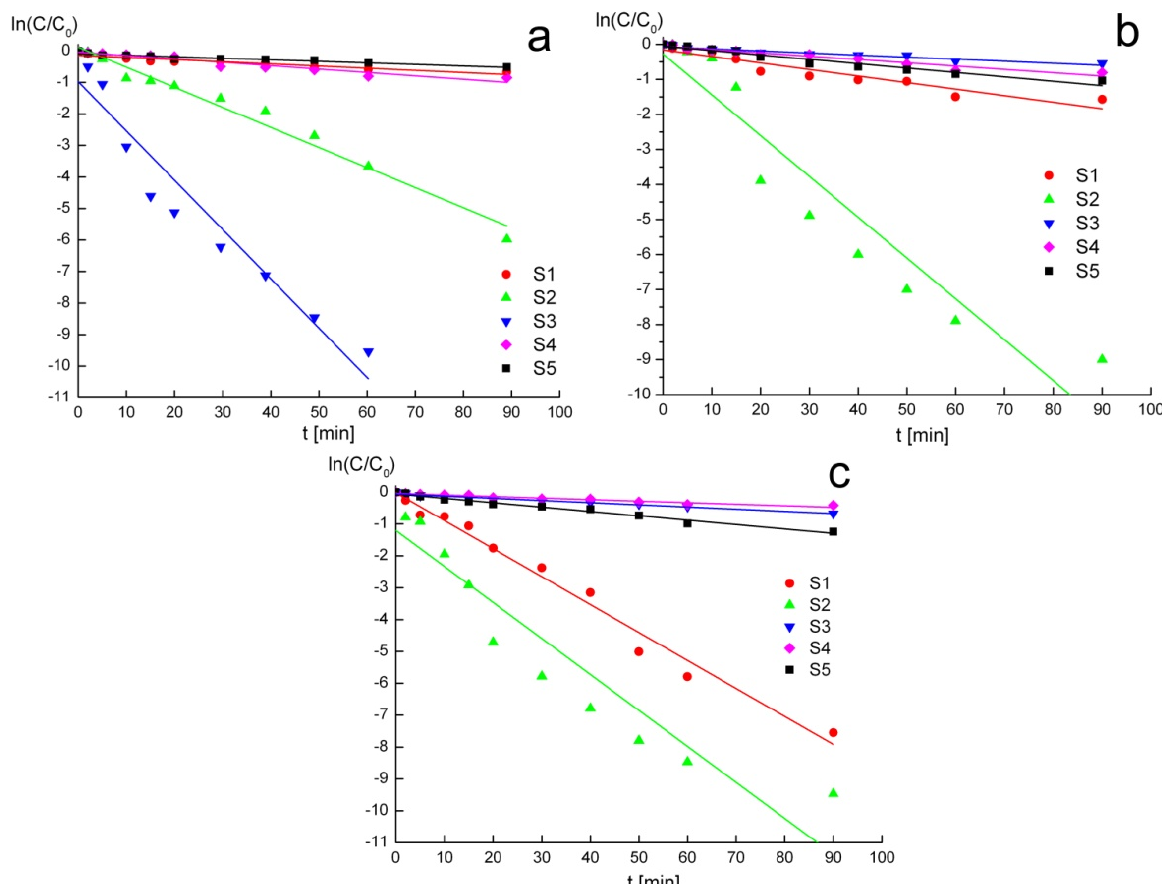
Figure 9. The kinetic curves of the photocatalytic decomposition of Rhodamine B ( a ), Reactive Red 6C ( b ), and Methylene Blue ( c ). Table 7. Kinetic parameters of photocatalytic destruction of dyes.